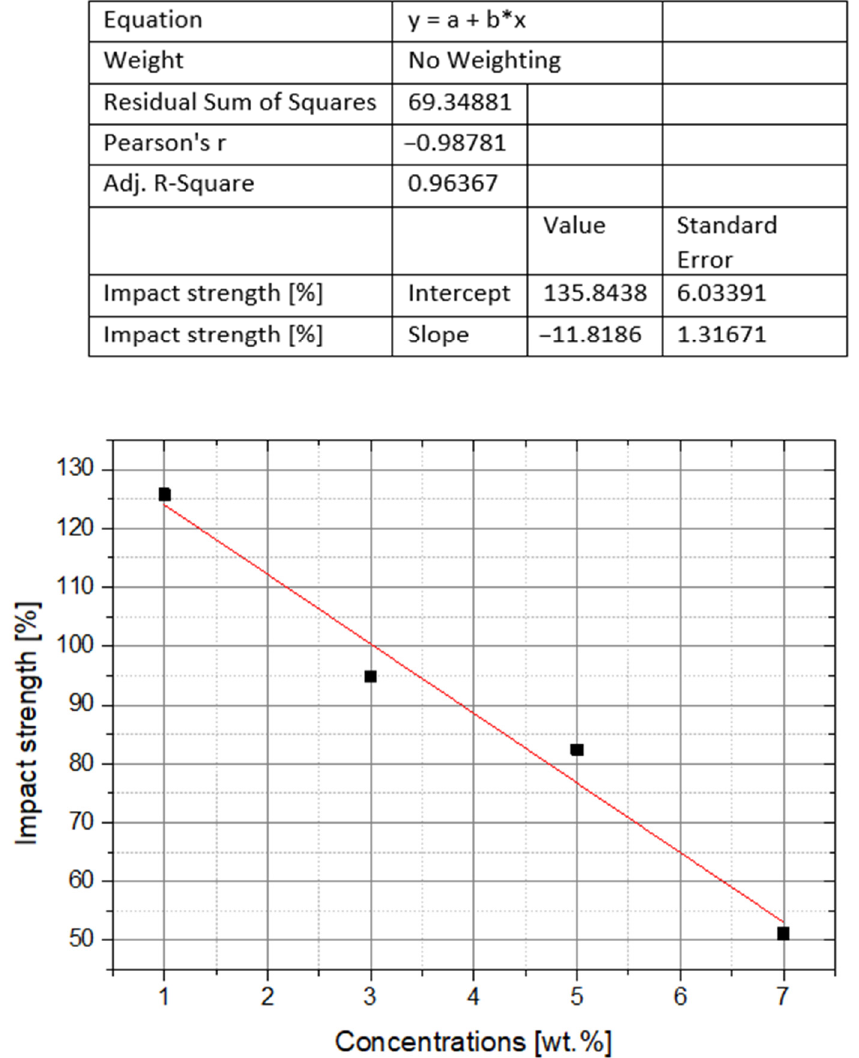
Figure 5. The effect of nano-ZrO 2 additive concentration on the impact strength of PMMA composites. The results of individual studies.